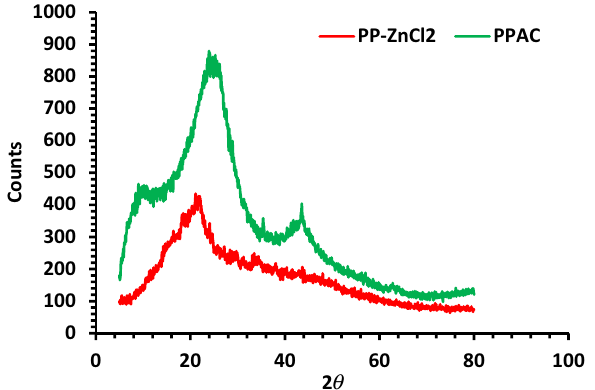
Figure 1. XRD investigation of Pea peels ( Pisum sativum ) soaked with ZnCl 2 (Red) and PPAC prepared at 800 °C in the presence of CO 2 gas flow